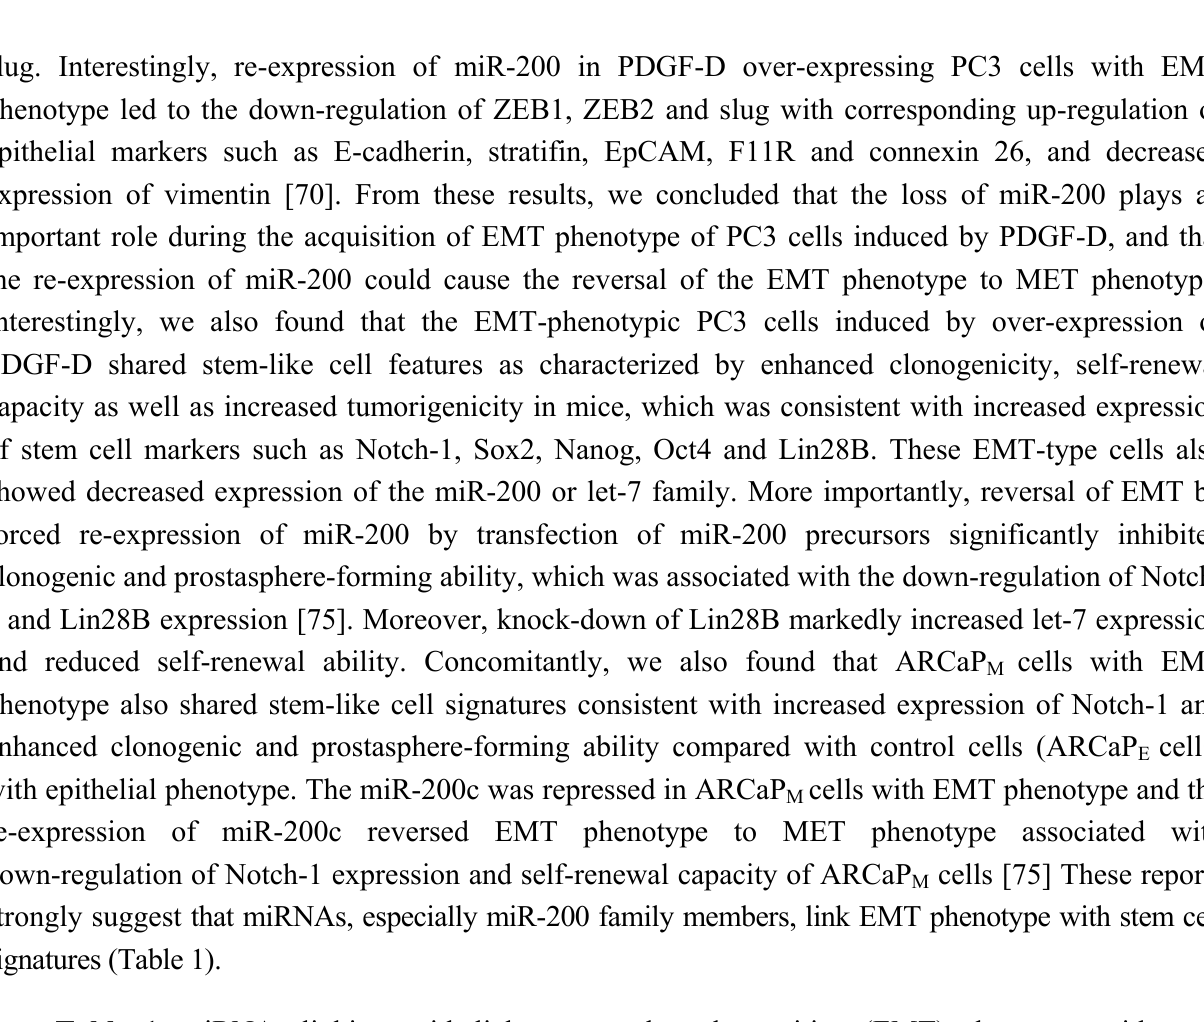
Table 1. miRNAs linking epithelial-to-mesenchymal transition (EMT) phenotype with stem-like cell signatures in human